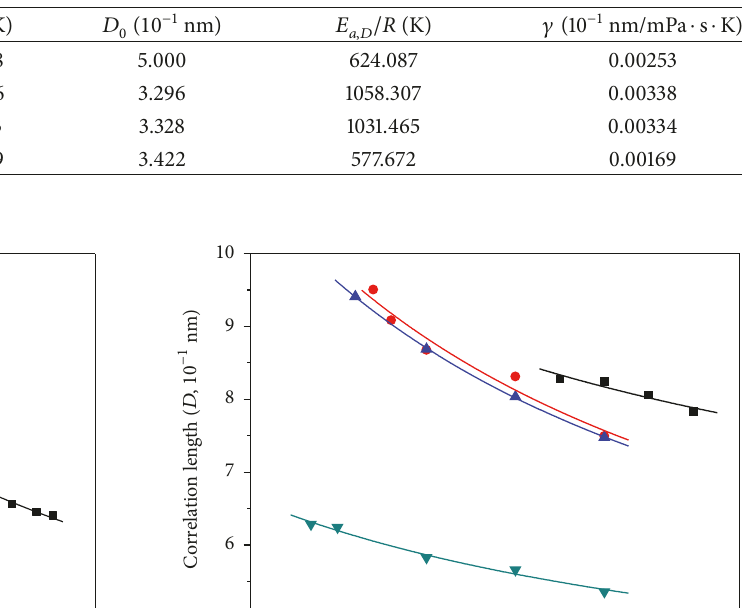
Table 1: Parameters 𝜂 0 ,𝐸 𝑎,𝑉 /𝑅, 𝐷 0 ,𝐸 𝑎,𝐷 /𝑅, 𝛿 , and 𝛾 of the Cu-Sn melts.